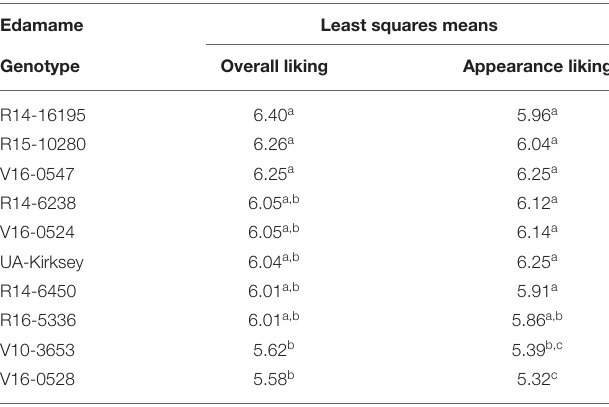
TABLE 2 | Consumer acceptability of edamame genotypes. Edamame